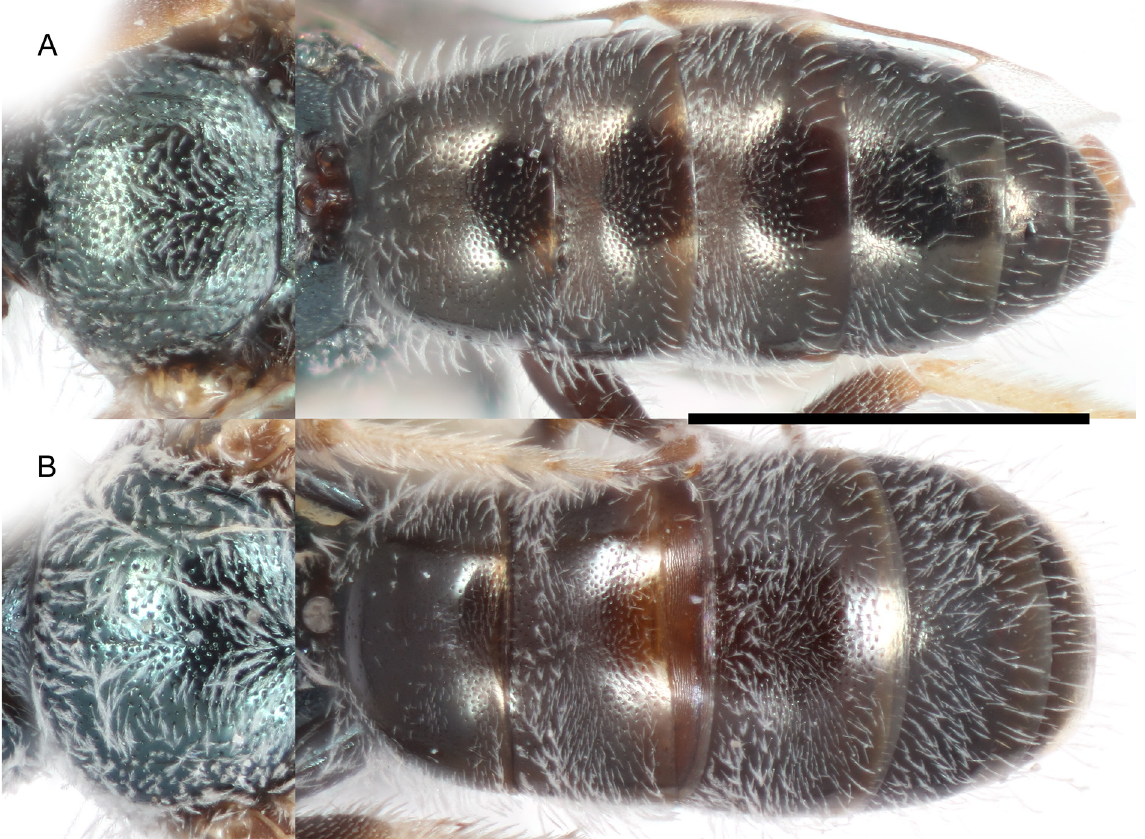
Fig. 117. Mesoscutum and metasoma. A . Lasioglossum ( D. ) clematisellum (Cockerell, 1904), with most hair thin and simple. B . L. ( D. ) julipile sp. nov., with most hair densely plumose. Scale bar: 1